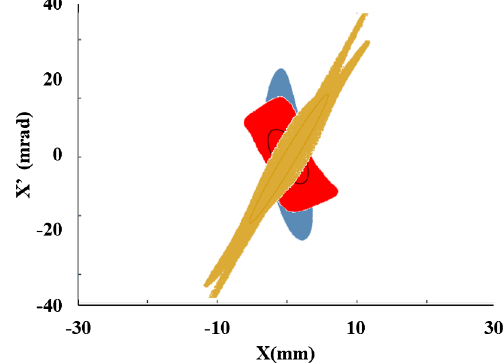
FIG. 8. Transverse emittance at the end of the beam line using the solenoid field for different H − beam currents: zero current (blue), 10 mA (red), and 30 mA (yellow).